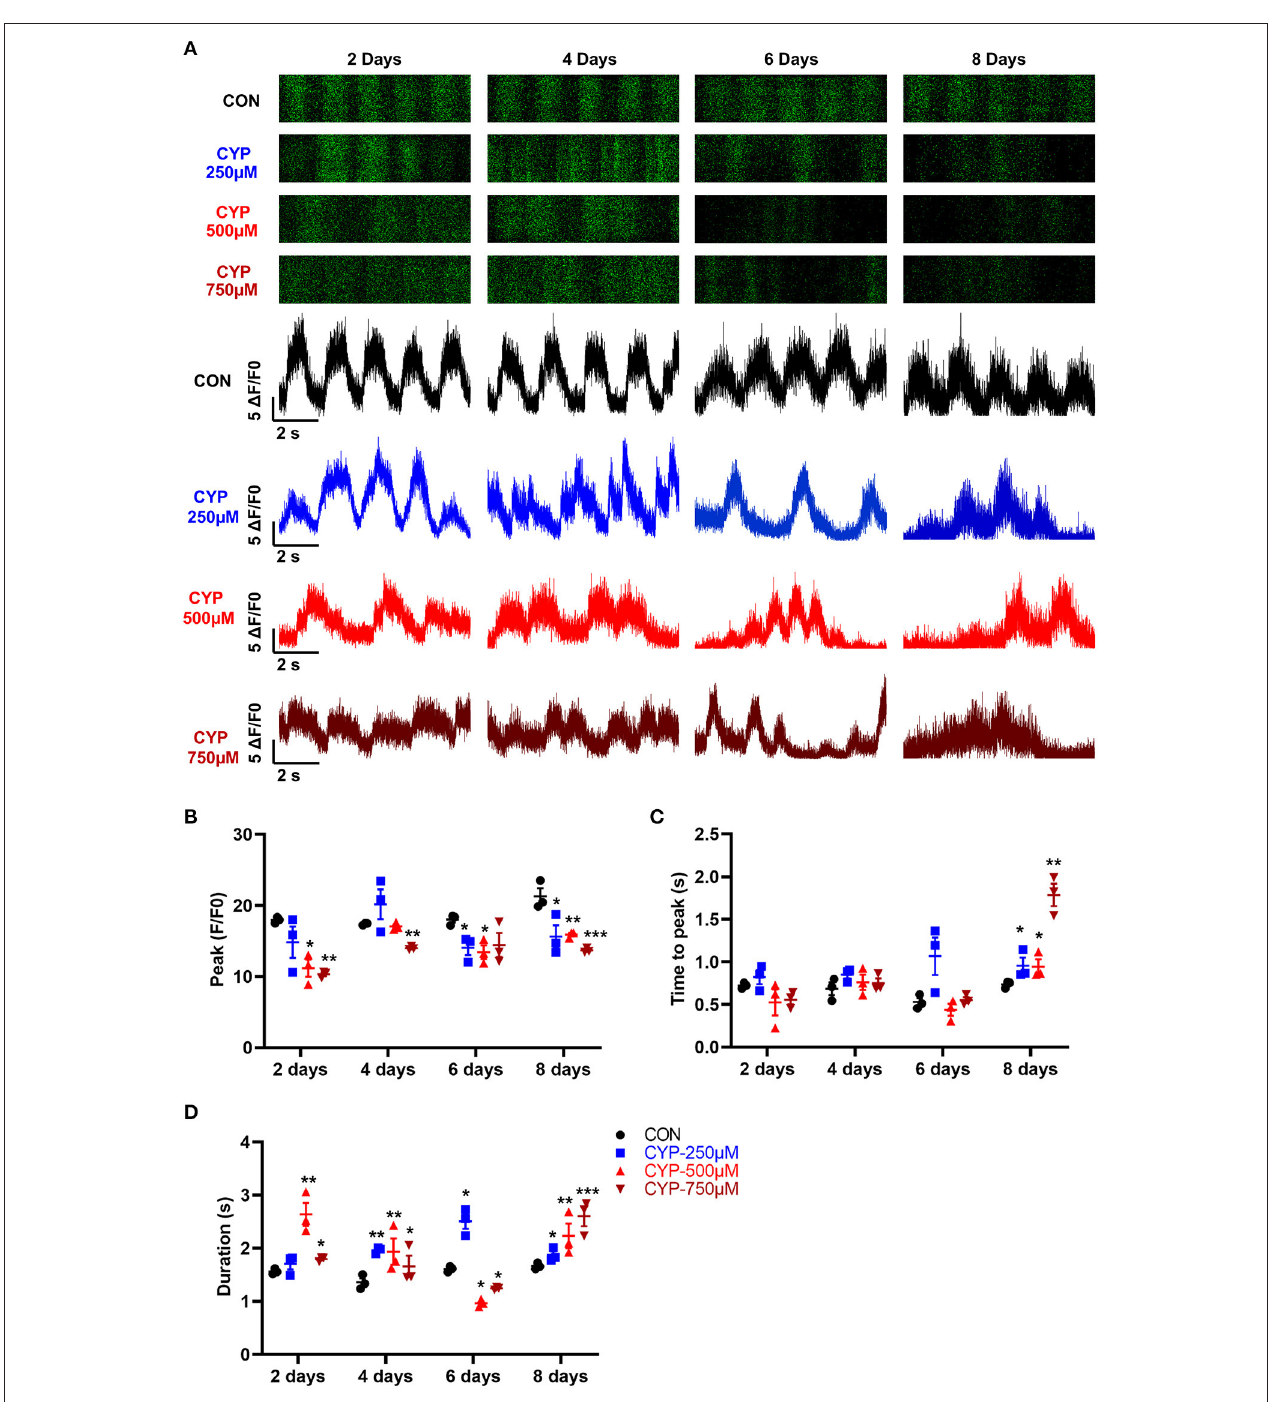
FIGURE 5 | hESCs-CMs treated with CYP exhibited abnormal Ca 2 + handling properties. (A) Representative line-scan images in H9-GCaMP cell-derived cardiomyocytes treated with different concentrations of CYP at 2, 4, 6 and 8 days. Quantification of peak (B) , time to peak (C) , and calcium transient duration (D) in CON and CYP-treated H9-GCaMP-CMs. The data are shown as the mean ± SE, n = 3. * P < 0.05, ** P < 0.01, *** P < 0.001 vs. CON.